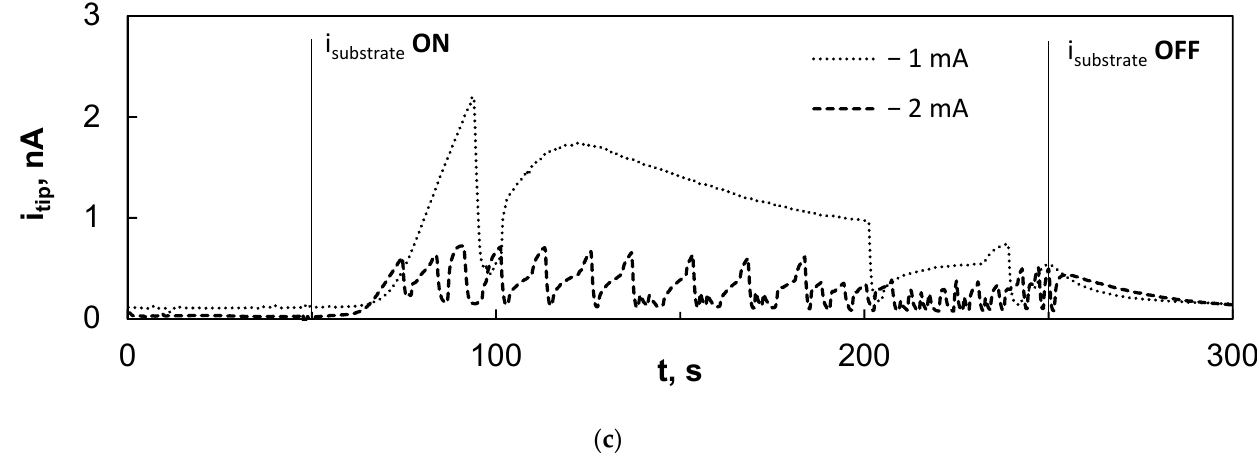
Figure 6. The results of the electrochemical behavior experiments of fs-Cu/MoS 2 in the SECM: ( a ) LSV curve; ( b ) settling of the substrate overpotential under different applied currents; ( c ) the kinetics of the probe response to the substrate generation signal.